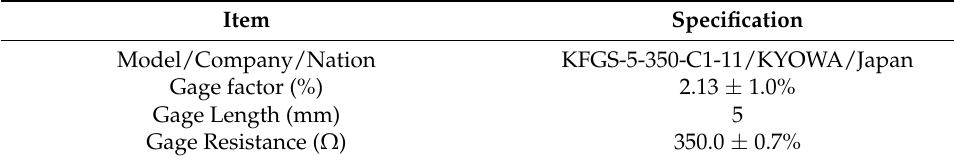
Figure 7. Attachment point of the strain gage. Table 2. Specification of strain gage.